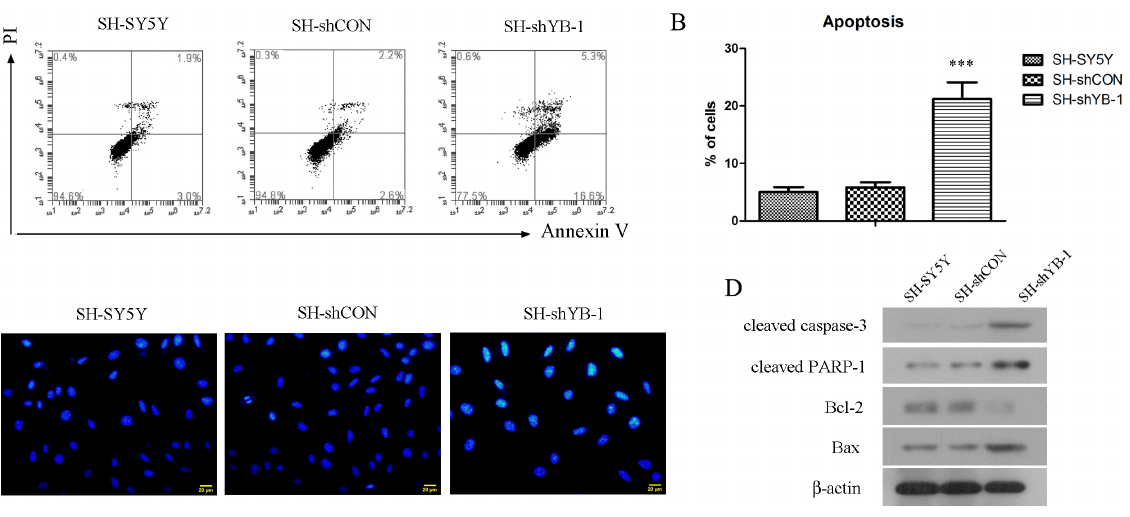
Fig 4. YB-1 silencing induced apoptosis in neuroblastoma cells. (A) SH-SY5Y, SH-shCON and SH-shYB-1 cells were double stained with anti-Annexin- V-FITC antibody and PI, followed by FACS analysis for cell apoptosis. Cells that fell in the lower right quadrant were characterized as early apoptotic cells which were statistically analyzed in B. (C) Cells were incubated with Hoechst stain, whereby the fluorescent stain that was taken by the apoptotic cells bound to DNA and emitted fluorescence under a fluorescent microscope. (D) The levels of several critical apoptosis markers were examined by Western blot analysis with β -actin as the internal control. The figure shows the representative images of three independent experiments, and the values are expressed as mean ± standard deviation. Compared with SH-SY5Y control, *** P < 0.001.